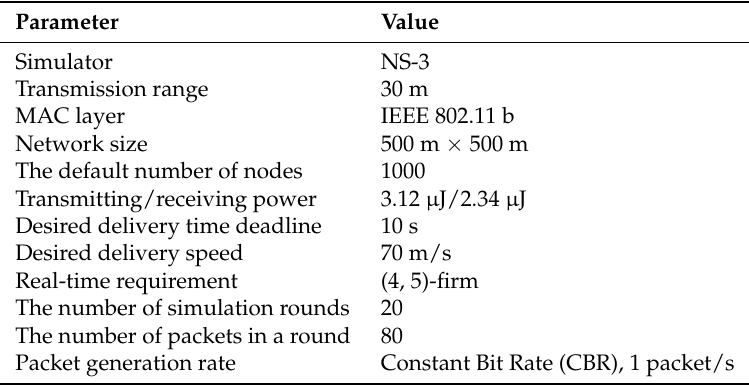
Table 1. Summary of simulation